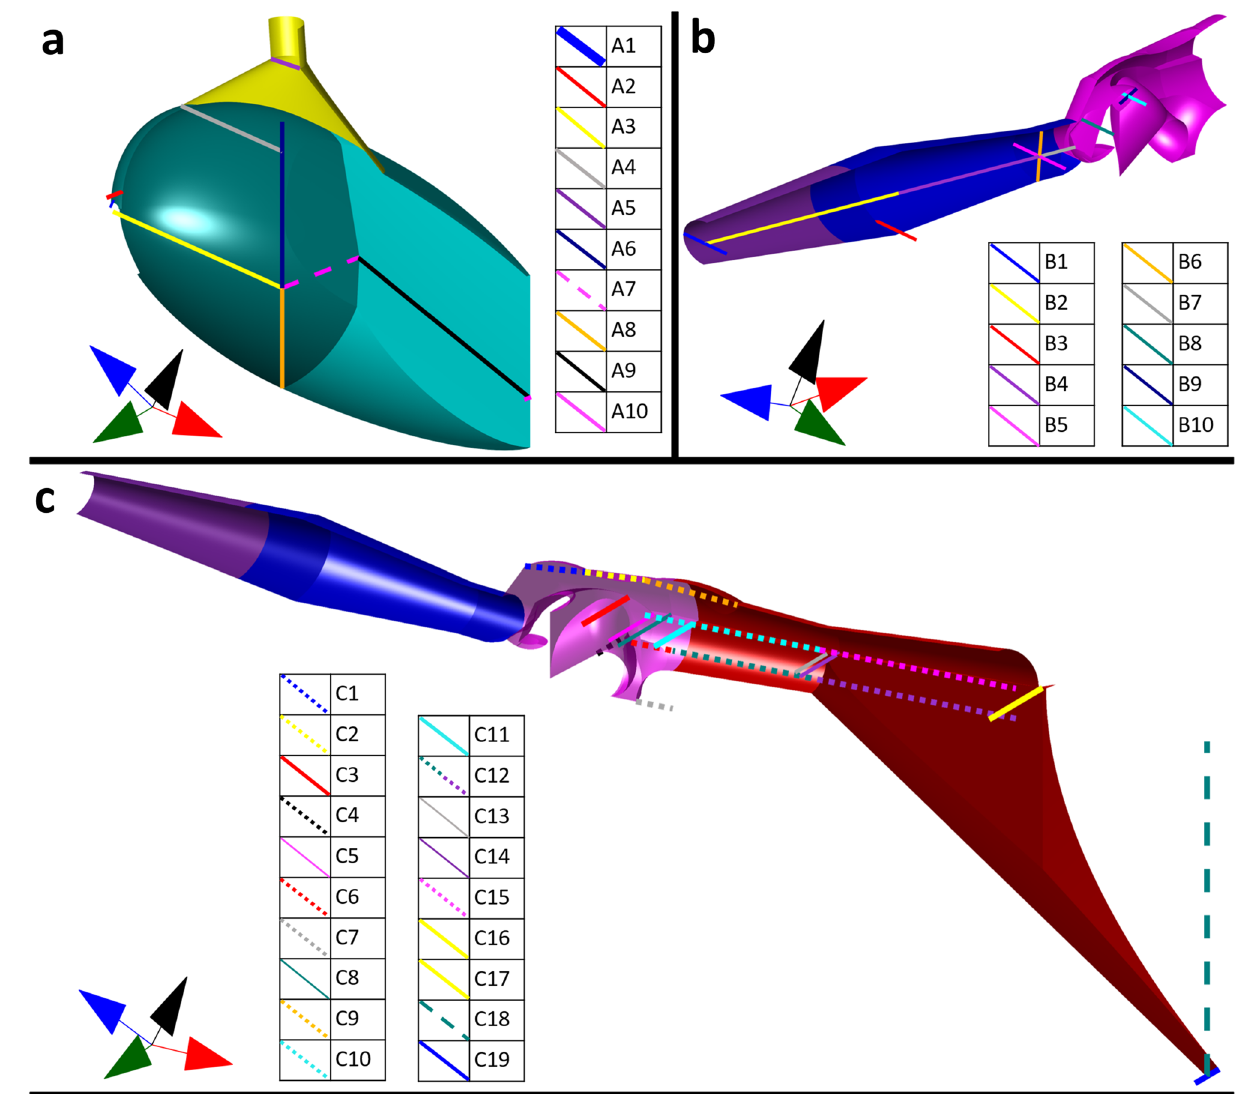
Figure 1. Dimensions of the 3D model for the functional foregut of the blue–green sharpshooter, as detailed in the Supplementary Information (Table S1). All views shown are internal (concave). ( a ) Left half of the true mouth (yellow) and cibarium (teal). ( b ) Left half of the HEF (purple), distal enclosure (blue), and basin (magenta). ( C ) Left half of the precibarium. The basin is partially translucent to make dimension C4 visible. The coordinate axes indicate anterior → posterior, distal → proximal (for the trough), ventral → dorsal, and left → right. The dimensions are indexed based on the subfigure in which they appear. For example, A7 is the seventh dimensional measurement that is illustrated in figure 1a. The 3D model segment color coding is explained in Figs. 2 and 3. HEF: hypopharyngeal extension that inserts into the stylet food